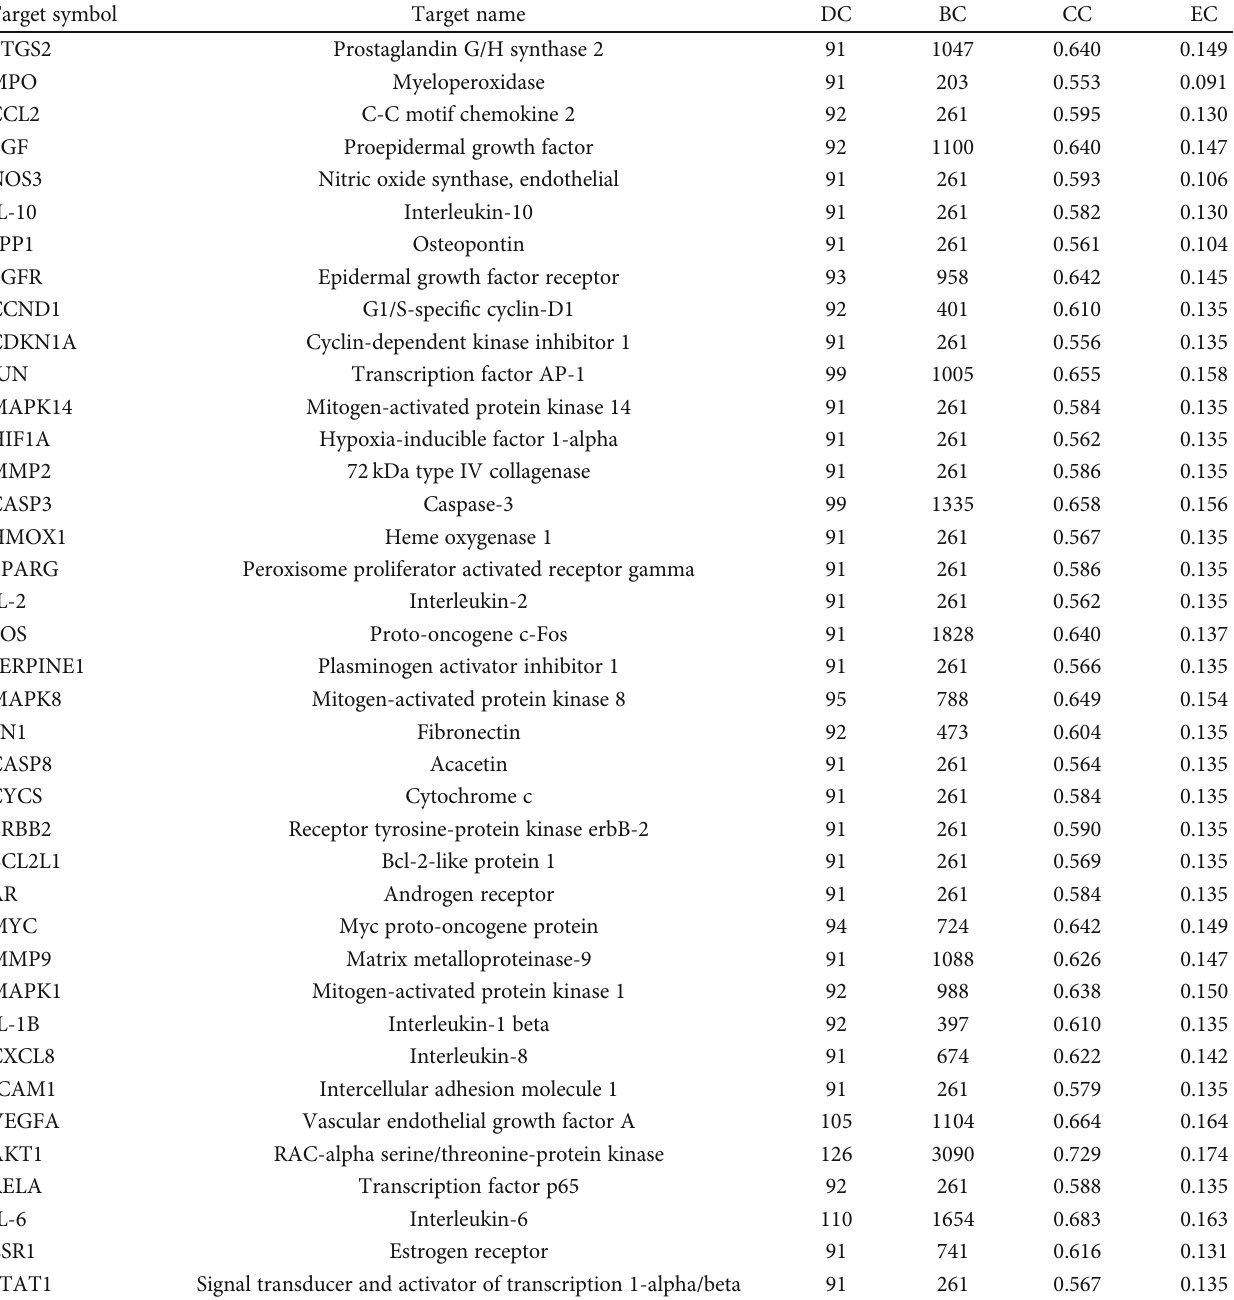
Table 3: The 39 key targets of HLJDD in treating